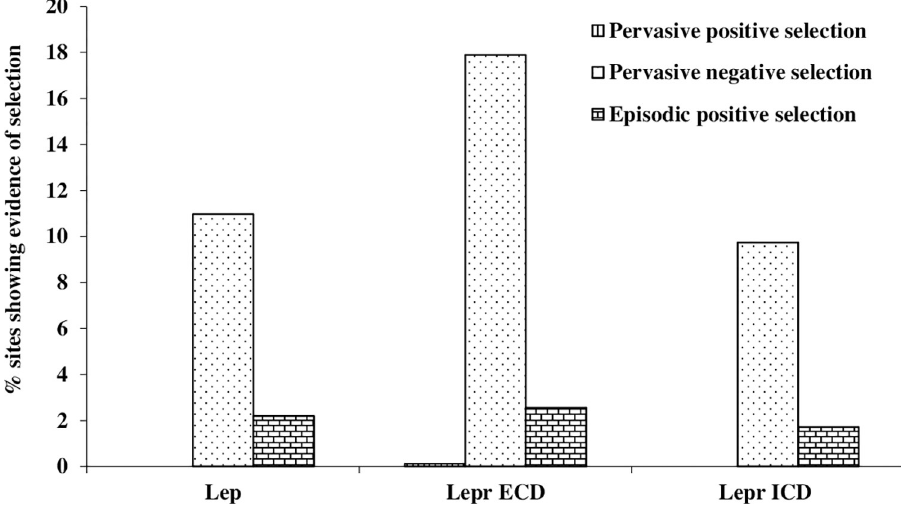
Fig 4. Bar diagram showing percent sites in leptin ( lepa ) and leptin receptor evidenced diversifying or purifying selection. Lep: leptin; Extracellular domain of leptin receptor (Lepr): ECD; Intracellular domain of leptin receptor: